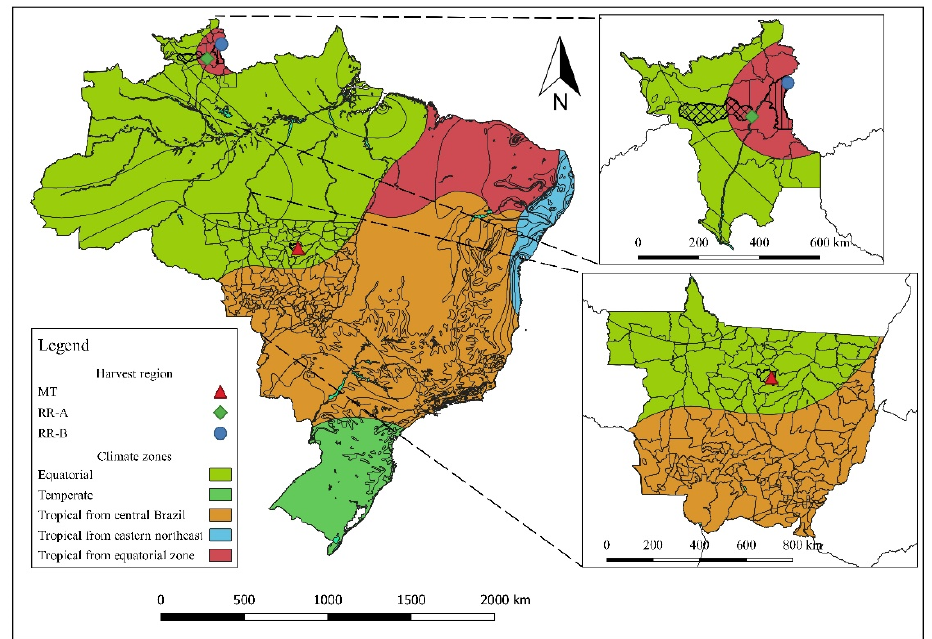
Figure 3. Map of climatic zones of harvesting areas.